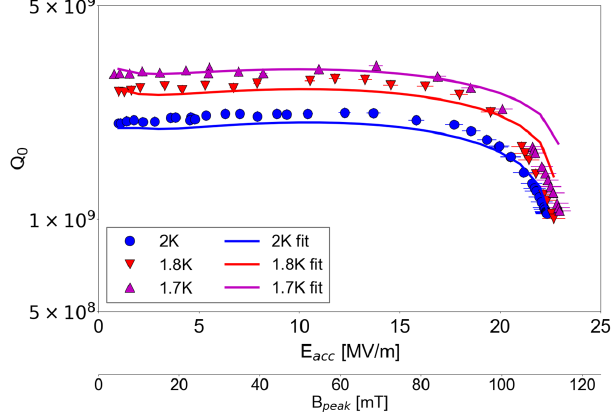
FIG. 10. Comparison between measured and calculated (fit) Q 0 vs E curves for cavity 3HZ015 at 2 K, 1.8 K, and 1.7 K. acc